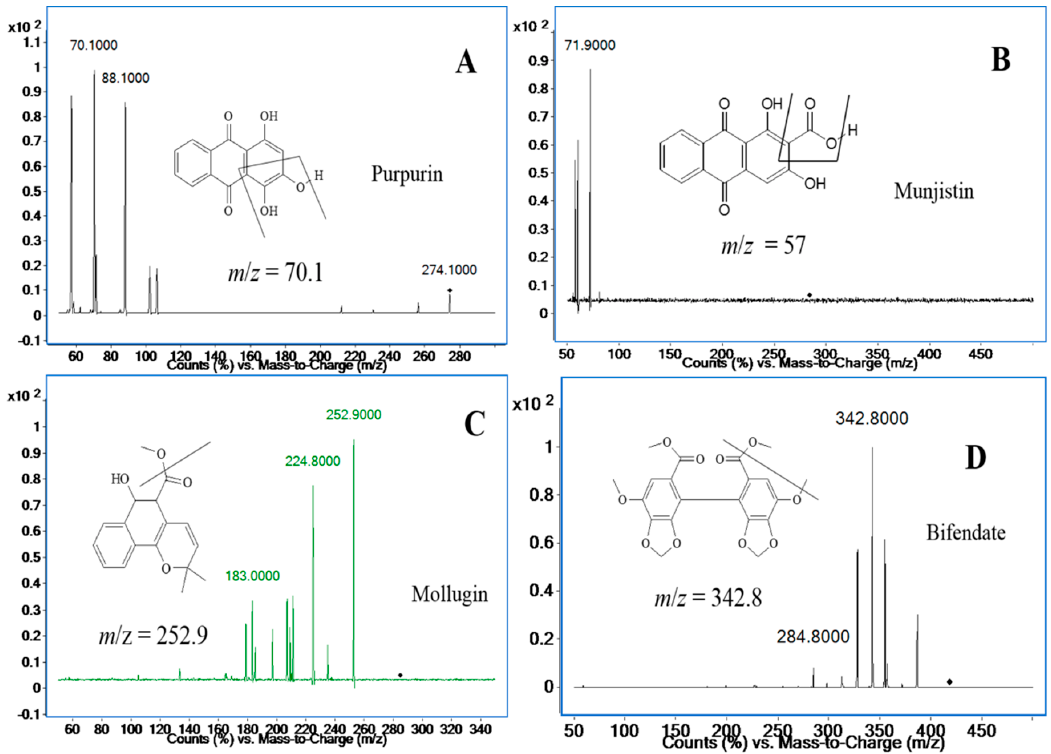
Figure 2. Product ion mass spectra of purpurin ( A ); munjistin ( B ); mollugin ( C ); and bifendate (I.S.) ( D ).